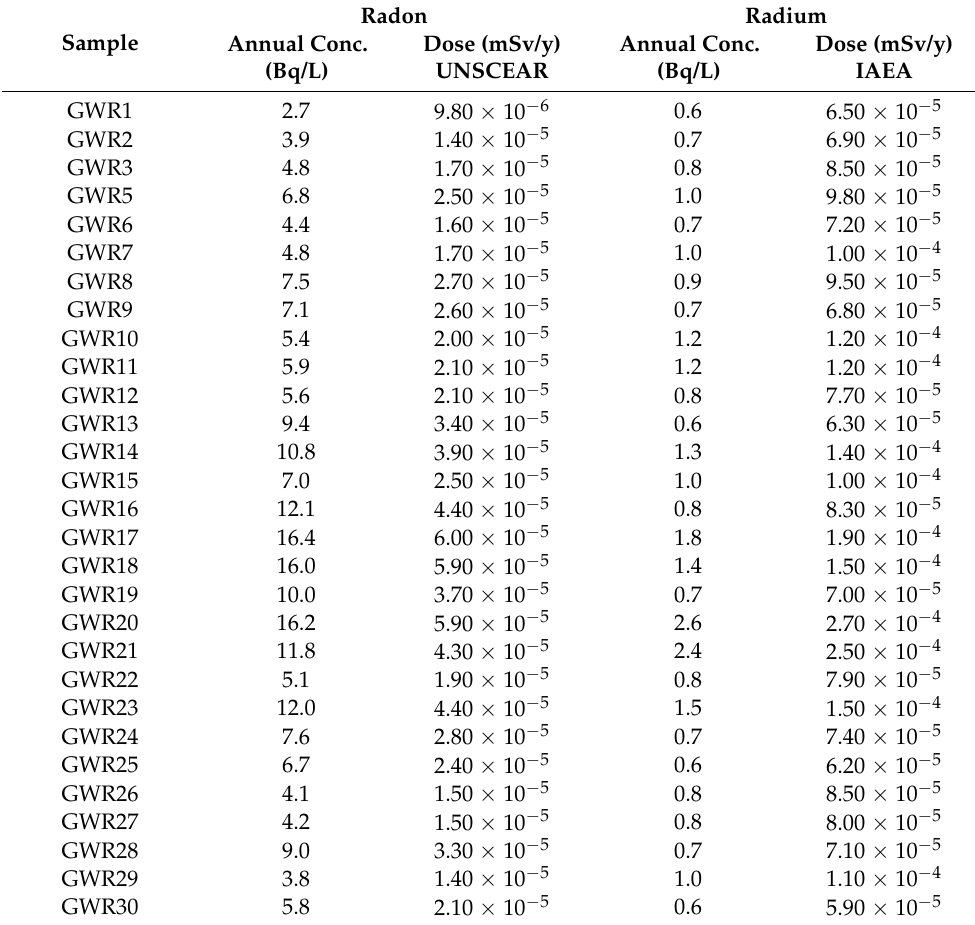
Table 4. Radon and radium annual activity concentrations and their associated dose calculated for the investigated karstic